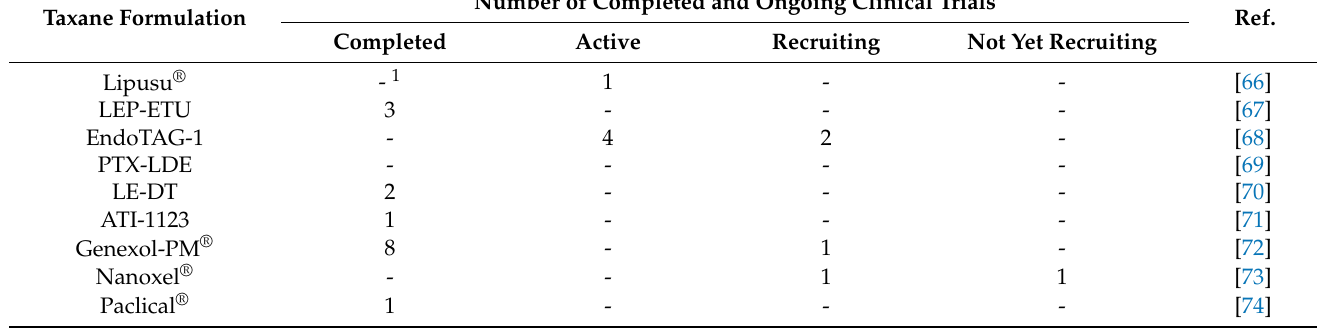
Table 1. Several completed and ongoing (active, recruiting, and not yet recruiting) clinical trials of novel nanosomal and micellar formulations of taxanes. Data from 22 nd of January 2021 Taxane